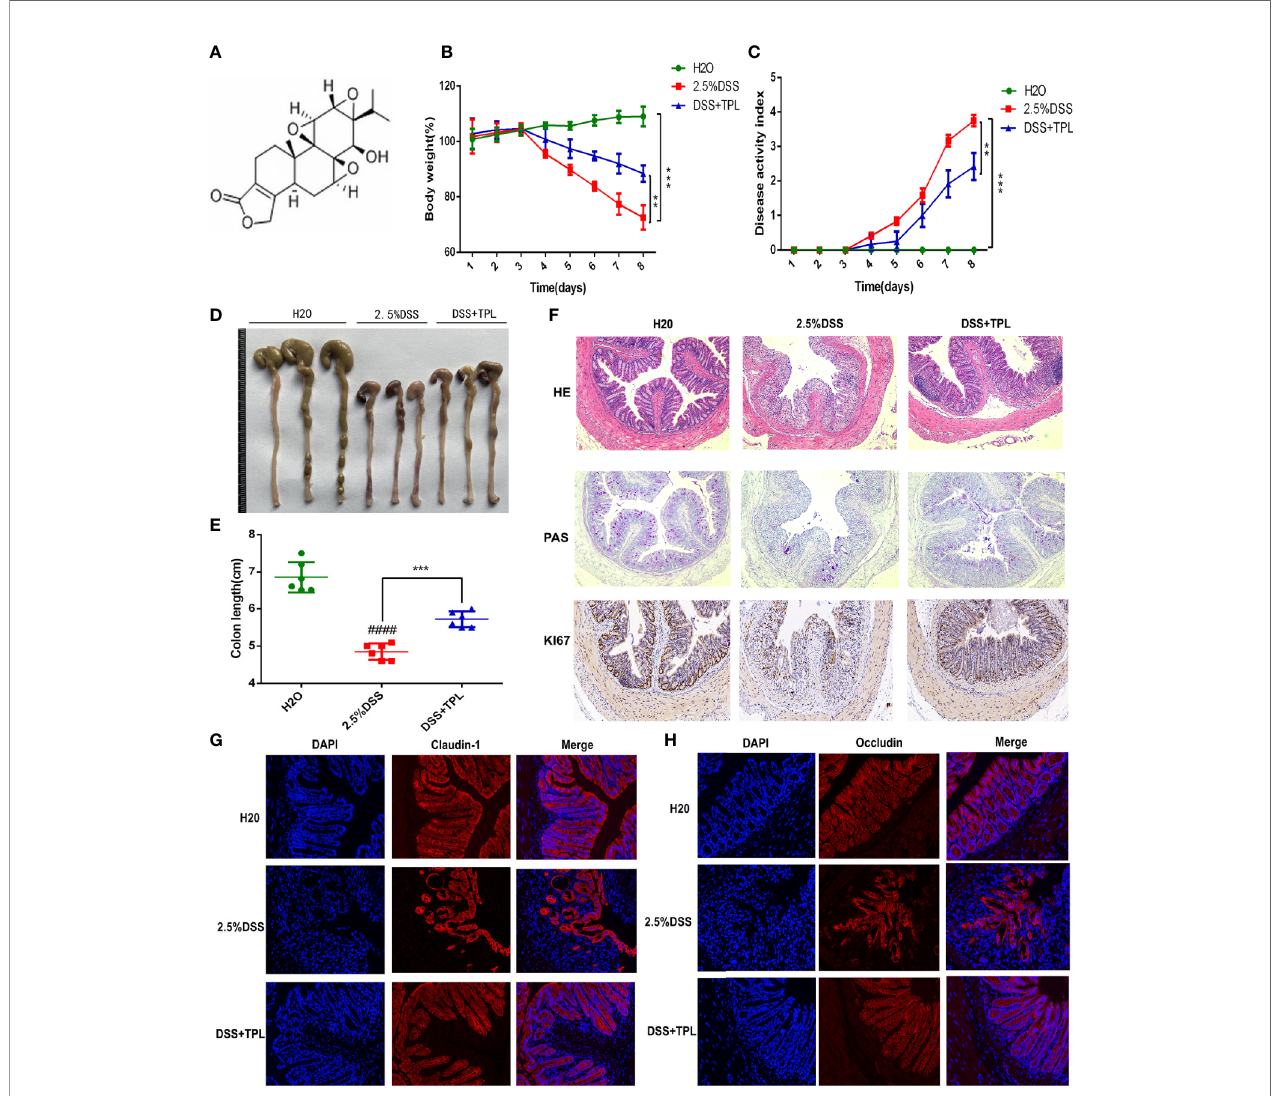
FIGURE 1 | The protective effect of triptolide on DSS-induced colitis mice. (A) The chemical structure of triptolide is shown. Mice aged 6 – 8 weeks were treated with 2.5% DSS with or without triptolide administration. (B) The body weight and (C) disease activity index (DAI) of these mice during the experimental period are depicted. (D – F) The pathological features of colitis are depicted by HE staining, PAS staining, and immunohistochemical assay of Ki67 levels. The expression of (G) claudin-1 and (H) occludin are indicated by immuno fl uorescence assay. Data are shown as the mean ± SD of at least three independent experiments. **P < 0.01; ***P < 0.001. #### means that the statistical difference between the results of the 2.5% DSS group and the H2O group was P <